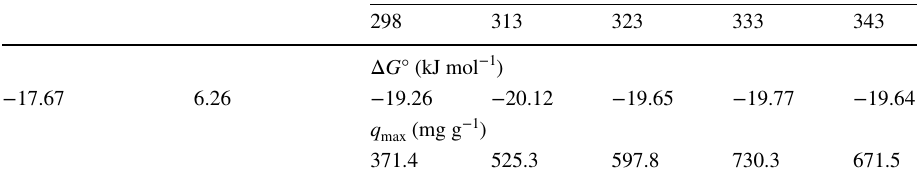
Table 5 Thermodynamics parameters for the adsorption of MV2B onto IA